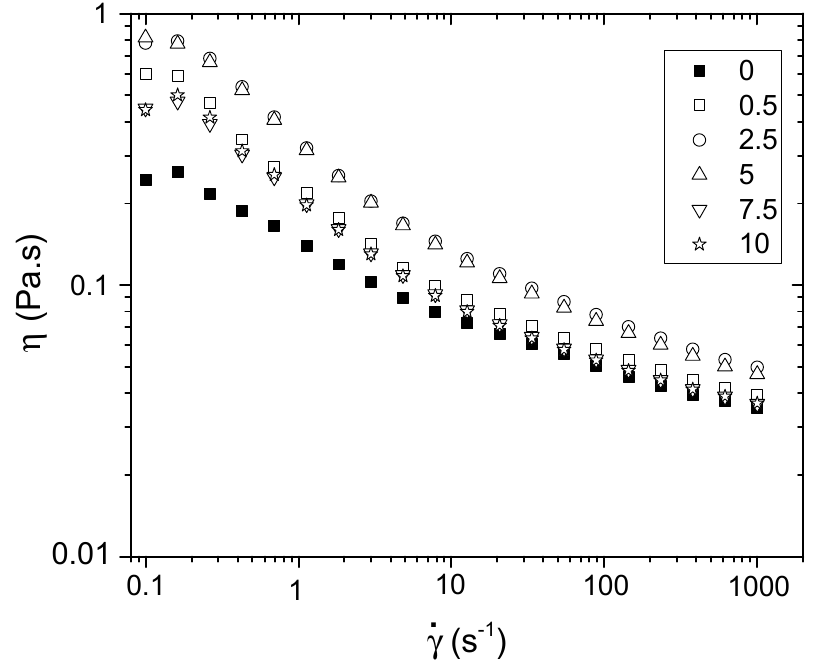
Figure 1. Log-log viscosity versus shear rate of film forming solutions of corn-starch and several ratios of CNC ( w / w ).